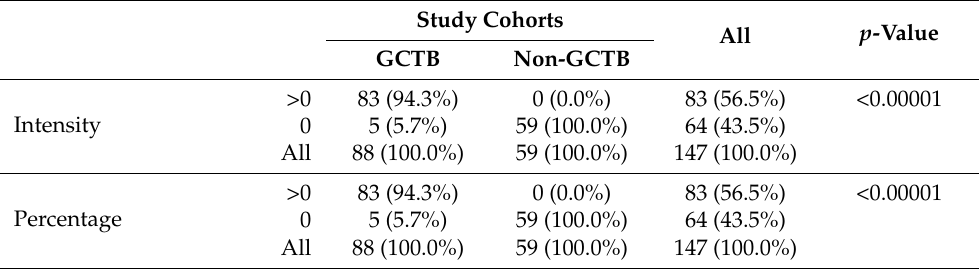
Figure 2. Immunohistochemical (IHC) analysis with anti-histone H3.3 G34W antibody in GCTB patients with p.Gly35Trp substitution. ( A ) typical radiological presentation of GCTB as an osteolytic, epiphyseal, locally aggressive lesion in distal left radius (RTG); ( B ) classical histology of GCTB with a fairly even distribution of osteoclast-like giant cells (H&E, 100 × ); ( C ) areas without crash artifact nuclear features of giant cells, similar to mononuclear cells. Cells with indistinct cell membranes (syncytial-like growth). No cytological atypia noted (H&E, 200 × ) ( D ) nuclear staining of mononuclear neoplastic cells was clearly visible against giant cells with no nuclear reaction (IHC, 100 × ). The results of the IHC analysis are shown in Table 3. Table 3. Results of immunohistochemical assays with anti-histone H3.3 G34W and G34V antibodies .